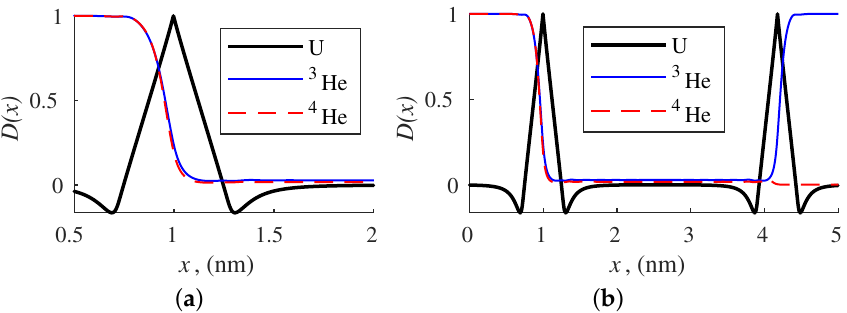
Figure 4. The probability density D ( x ) for helium isotopes passing through the one-layered ( a ) and two-layered ( b ) membrane of graphdiyne, T = 40.1 K, b = 3.17